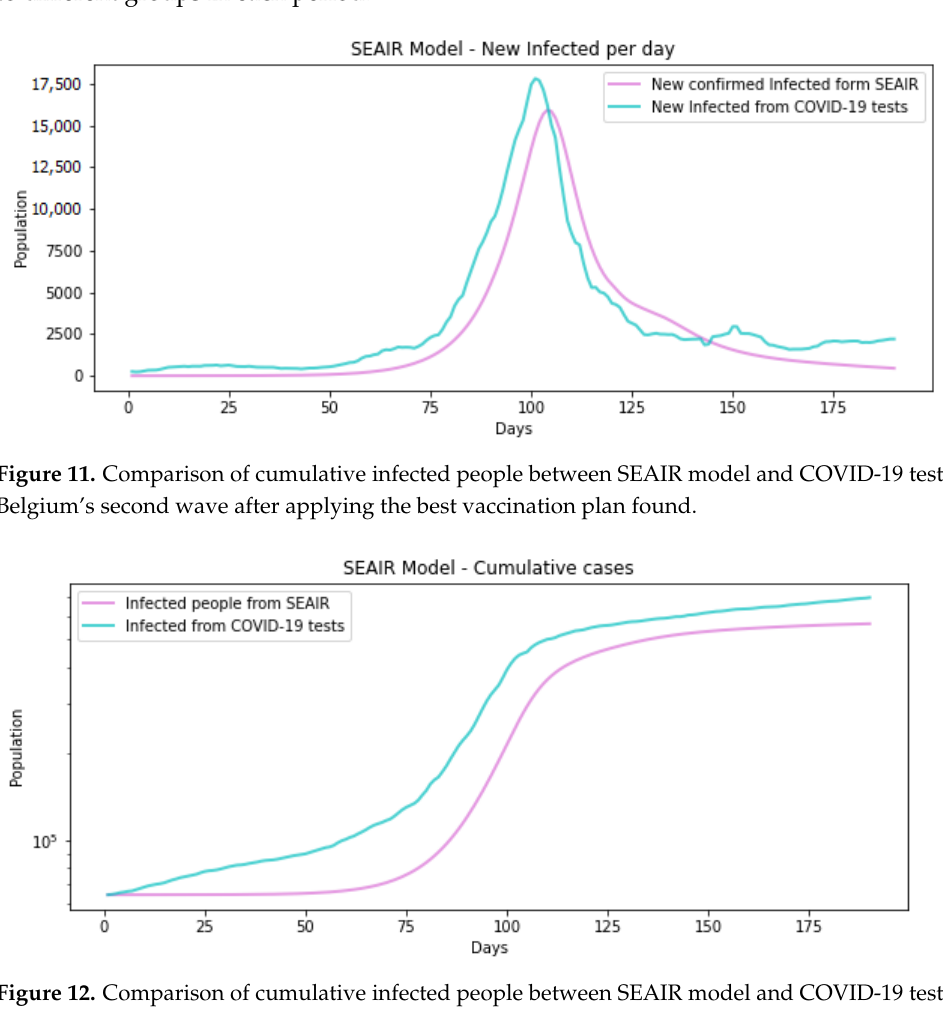
Figure 12. Comparison of cumulative infected people between SEAIR model and COVID-19 tests in Belgium’s second wave after applying the best vaccination plan found.